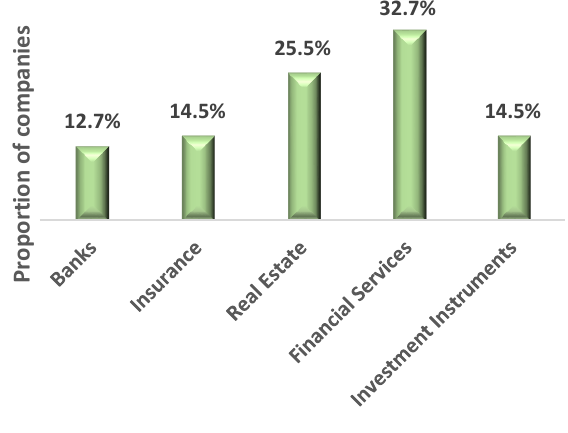
Figure 1: Sample by